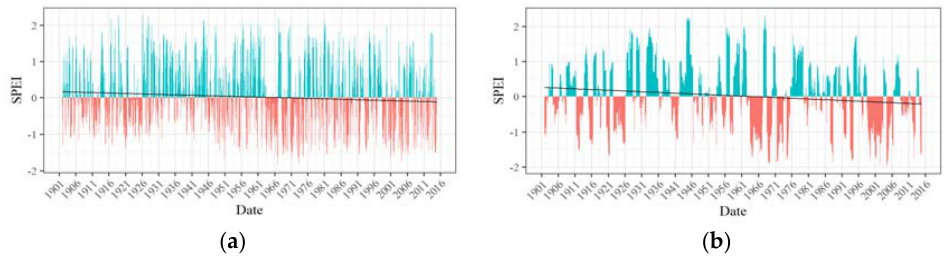
Figure 8. ( a ) 3-month and ( b ) 12-month SPEI time series of Zone Figure 8. ( a ) 3 ‐ month and ( b ) 12 ‐ month SPEI time series of Zone 4.